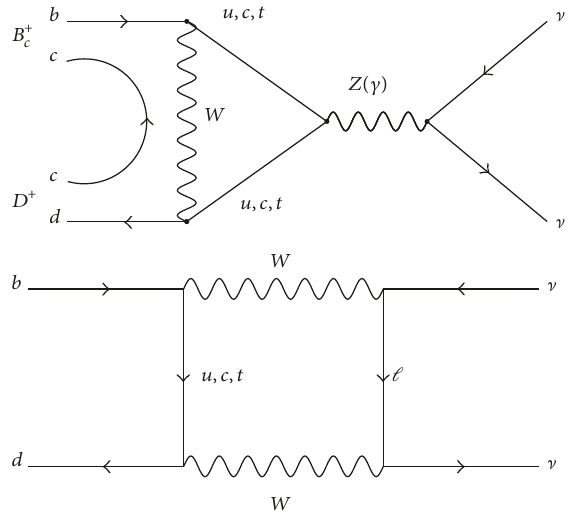
Figure 1: Loop diagrams for 𝐵 + 푐 → 𝐷 + ]] decay process.